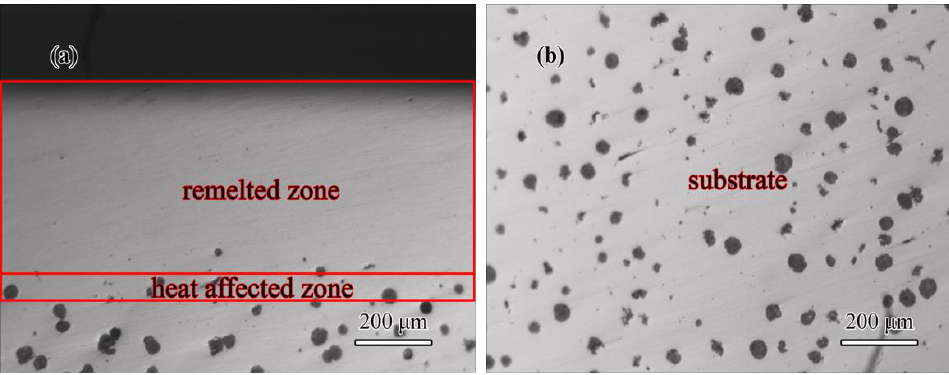
Figure 3. The graphite morphology in the remelted gradient layer fabricated by the plasma trans- ferred arc: ( a ) remelted gradient layer and ( b ) substrate. arc: ( a ) remelted gradient layer and ( b )